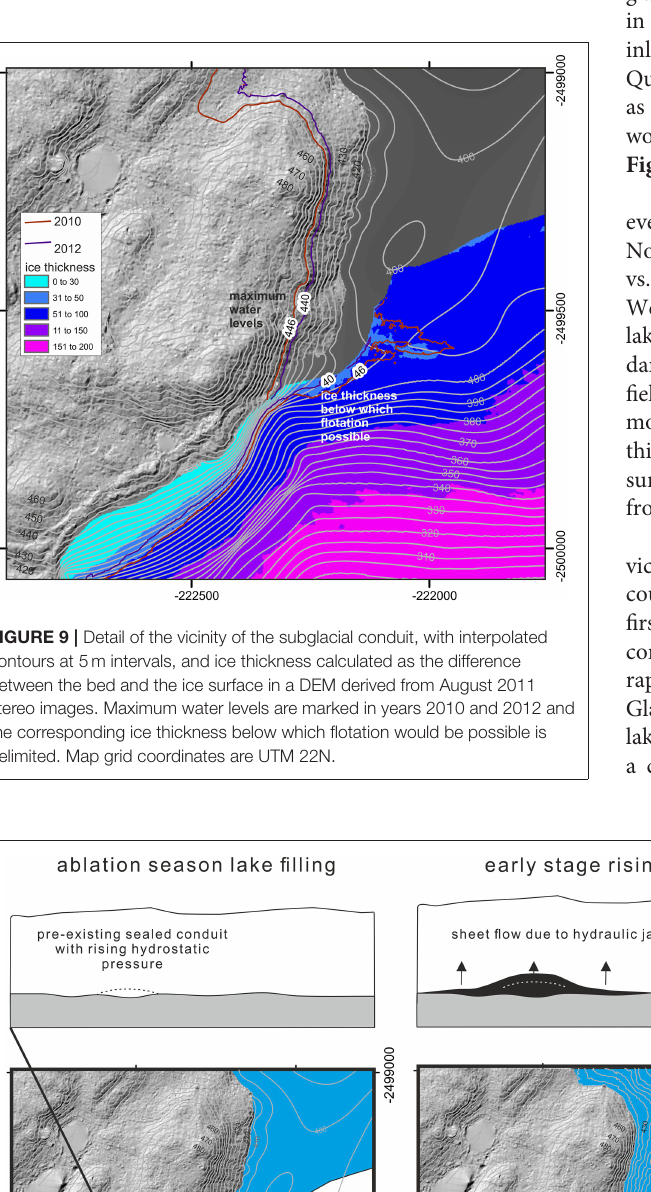
Frontiers in Earth Science |